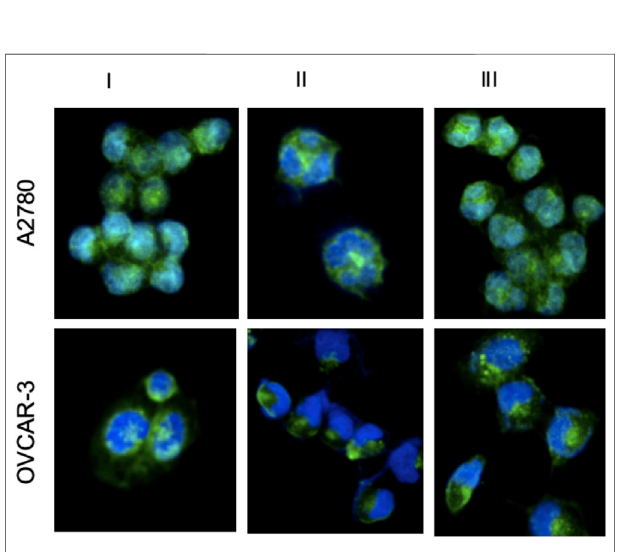
FIGURE8| DAPI stainingof24 hafter applyingRu complexes toA2780 and OVCAR-3 cells. (Blue for DAPI, Green for Ru complexes) (I, II, III represents for ruthenium complex I, complex II, complex III,